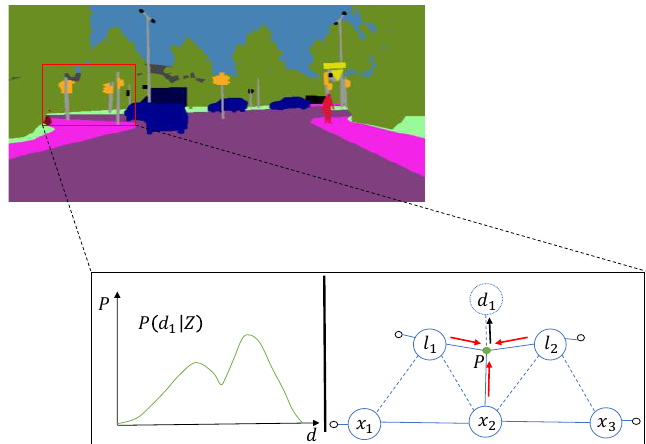
Figure 6. The illustrative overview of our proposed probabilistic data association approach. Top: Semantically segmented multiple objects with the same semantic label, and these objects are oc- cluded. Bottom: Finding the optimal combination based on the current expected measurement like- lihood model.